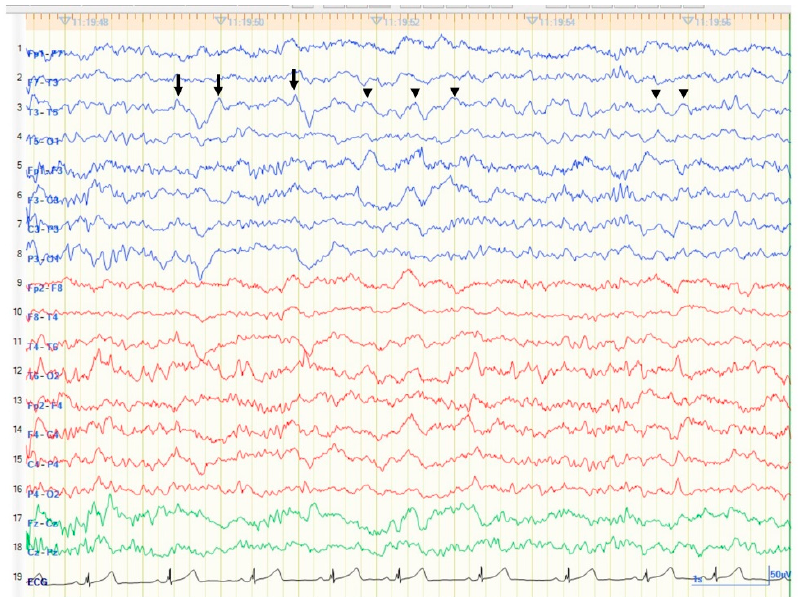
Figure 1. Scalp electroencephalogram of anterior–posterior bipolar montage using 10–20 International System shows medium to high amplitude sharply contoured focal slowing over the left mid-posterior temporal region (arrows). Monomorphic, medium amplitude 3–5 Hz delta and theta activities were seen in the same region (arrowheads).